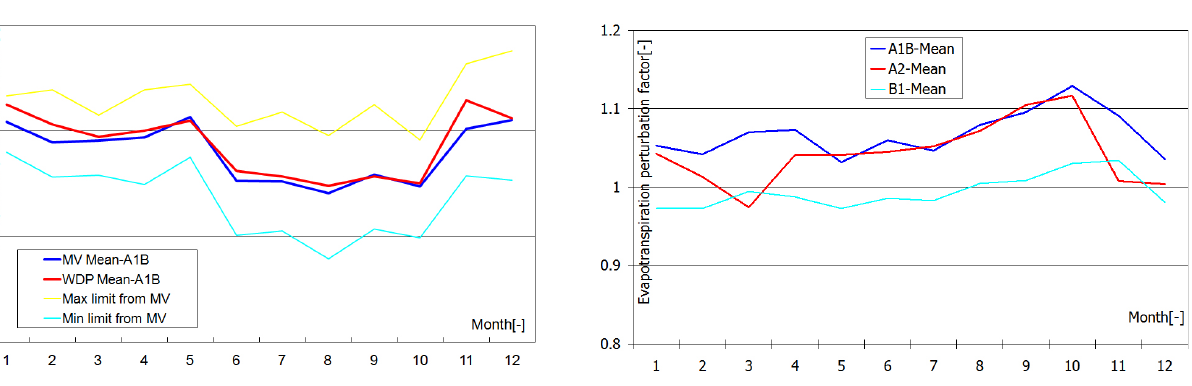
Fig. 8. Mean level of perturbation factor of monthly precipitation for A1B, A2 and B1 emission scenarios at BYBLK meteorological station.